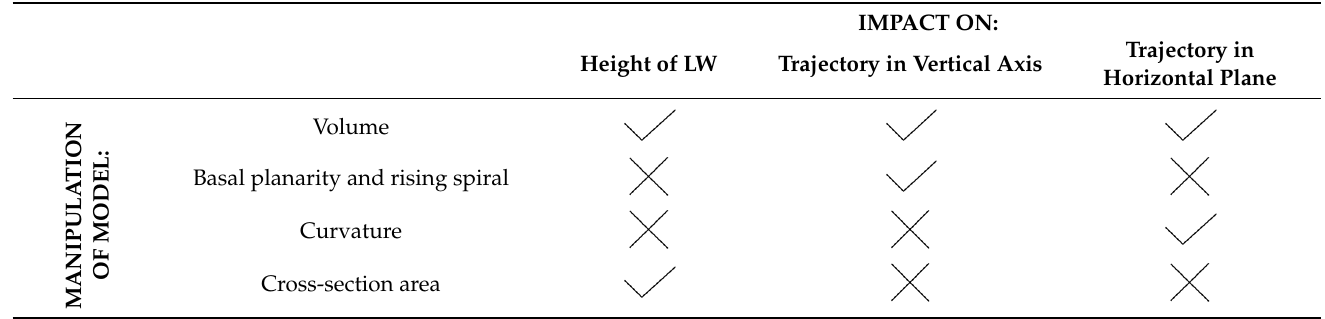
Table 1. Summary of manipulation of ST size/shape and its impact on ST height of the lateral wall, and trajectory of the CI in the vertical axis and horizontal plane.